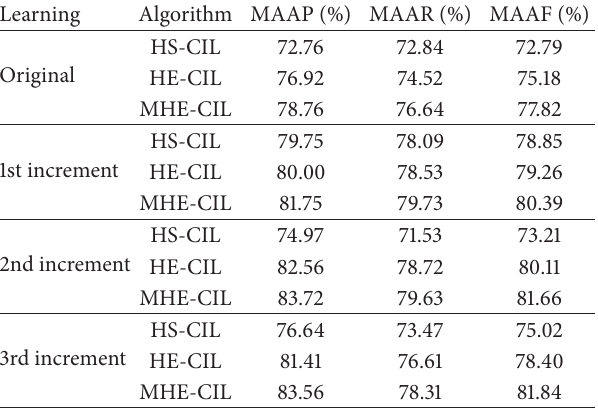
Table 2: The comparison of MAAP, MAAR, and MAAF. Learning